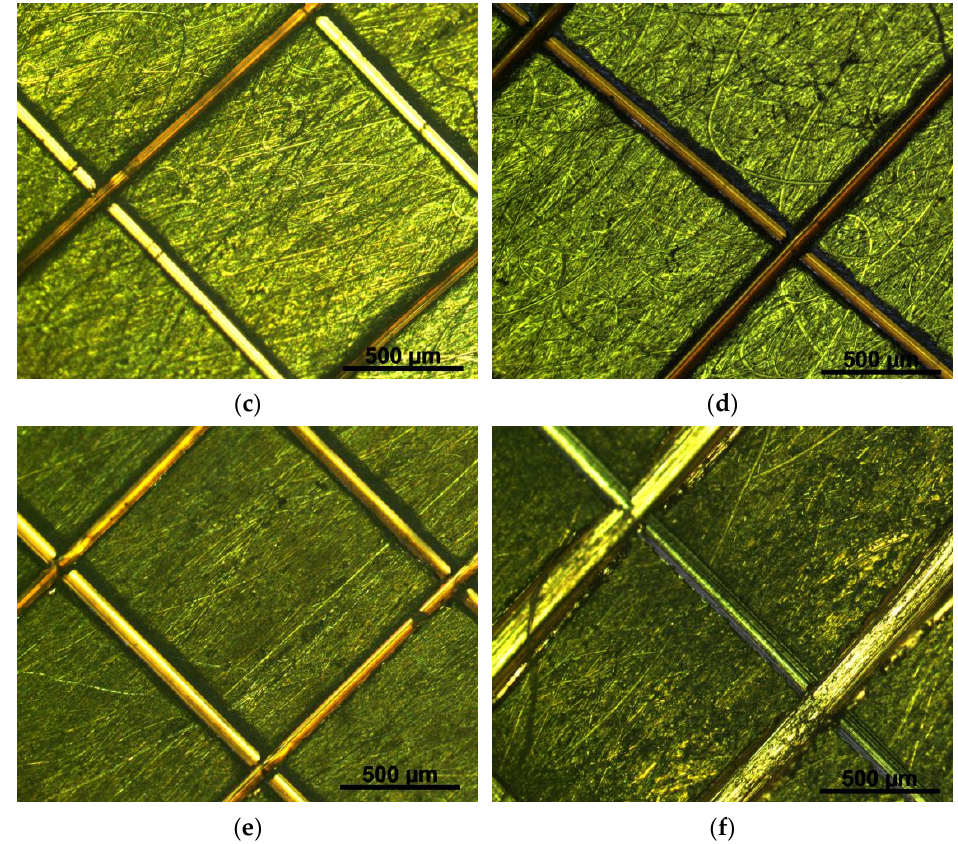
Figure 2. Microscopic enlargement of the coating after treatment at different temperatures ( a ) 20 °C, ( b ) 30 °C, ( c ) 50 °C, ( d ) 70 °C, ( e ) 90 °C, ( f ) 110 °C.